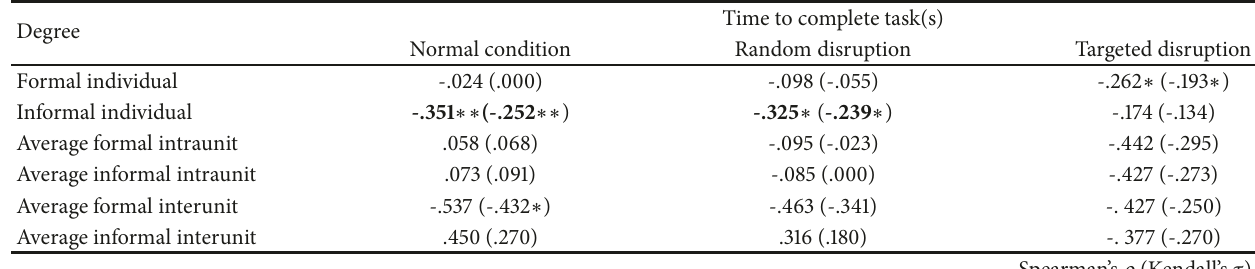
Table 11: Correlation between interdependence degrees and time to complete